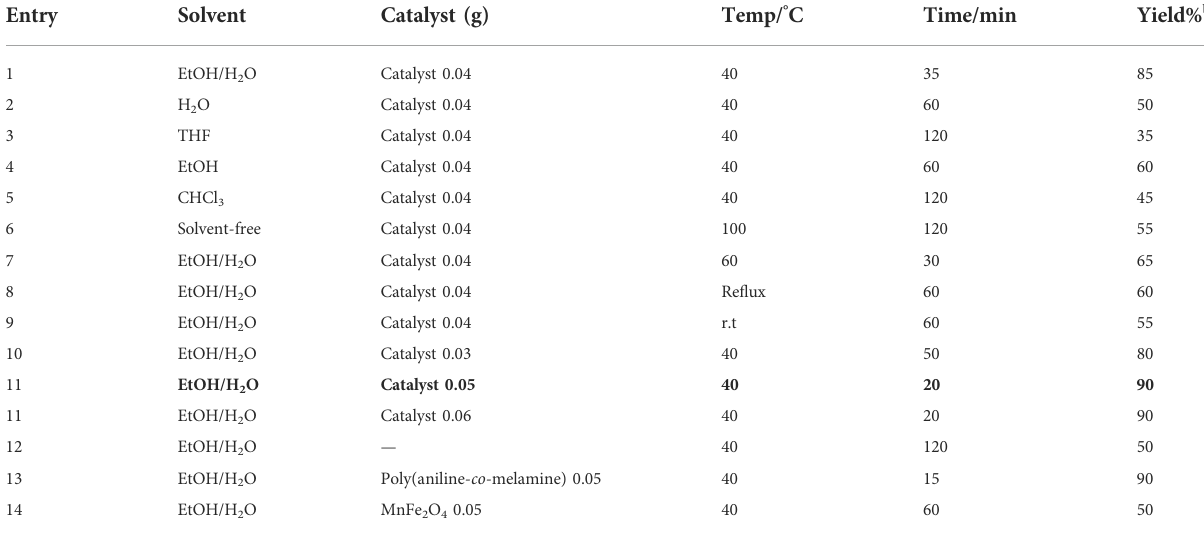
TABLE 1 Optimization of the three-component reaction of 3-methyl-1-phenyl-1 H -pyrazole-5-ol, benzaldehyde, and malononitrile under various conditions.